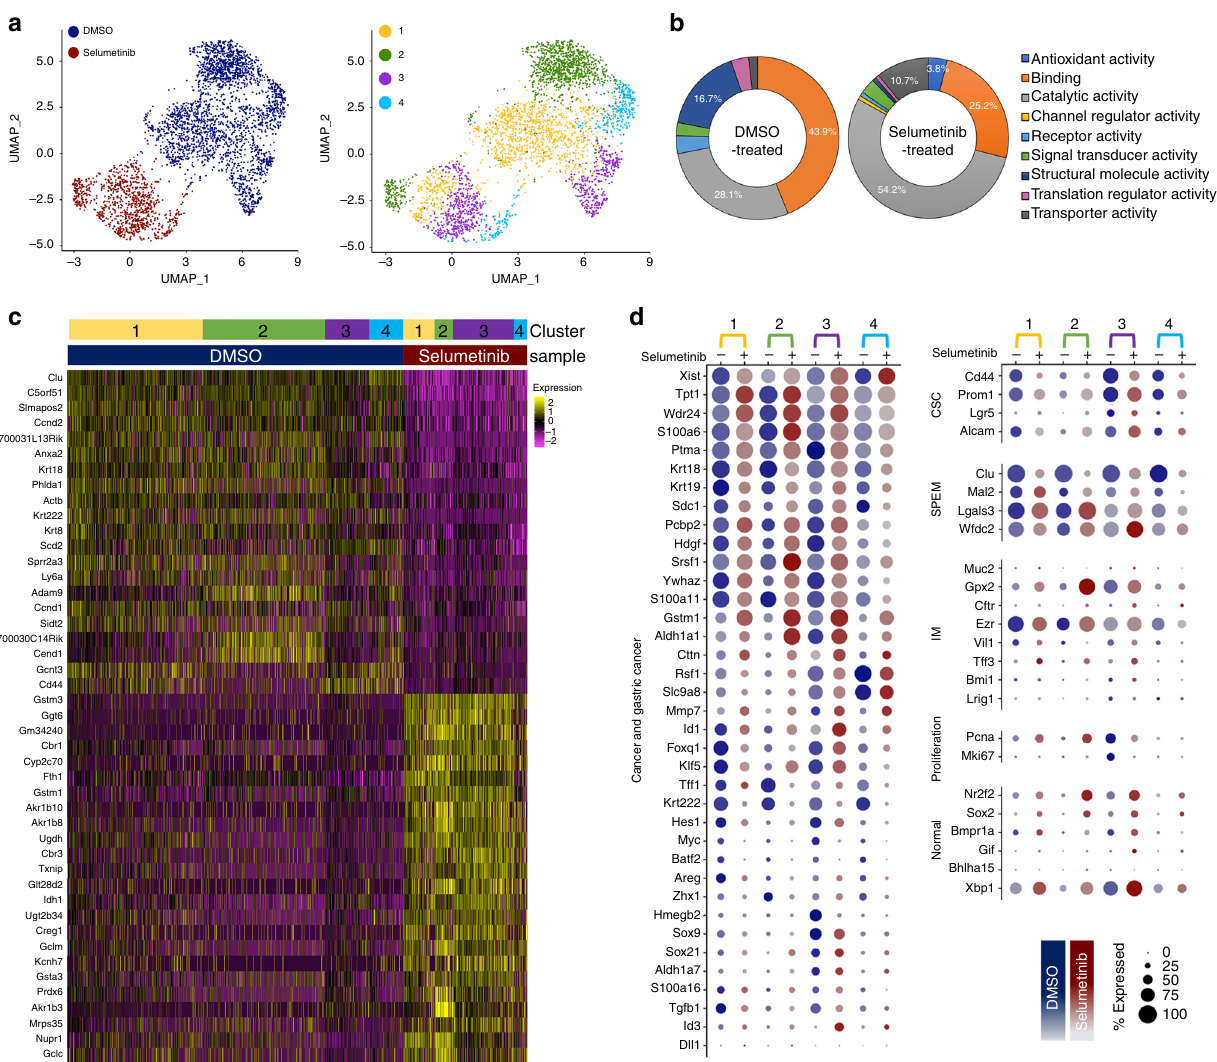
Fig. 6 scRNA-seq analysis of Meta4 cells treated with either DMSO or Selumetinib. a UMAP of DMSO-treated and Selumetinib-treated Meta4 samples with sample overlay (left) and subpopulation-matched cluster overlay (right). b PANTHER gene ontology classi fi cation results from DMSO vehicle-treated and Selumetinib-treated Meta4 samples. Top 300 differentially expressed genes in either DMSO vehicle-treated or Selumetinib-treated Meta4 samples were used for the analysis. c Heatmap of upregulated genes in DMSO vehicle-treated or Selumetinib-treated samples. Upregulated genes were de fi ned as those expressed in at least 50% of the cells in the sample with at least 0.75 log fold-change over the other sample. P -values were calculated using a two- tailed Wilcoxon Rank Sum test with Bonferroni correction and were <1e − 40 . Rows correspond to individual genes and columns are individual cells, arranged by sample and subpopulation. Yellow corresponds to high expression, black corresponds to neither high nor low expression, and purple corresponds to low expression. d Dot plots showing selected markers for cancer and gastric cancer (left), as well as markers for gastric cancer stem cells (GCSCs), SPEM, IM, proliferation, and normal gastric epithelium (right). Results are shown for matched subpopulations (1 – 4) and split by treatment (DMSO vehicle or Selumetinib). The dot size represents the percent of cells within the matched subpopulation with detected expression of the gene and color intensity re fl ects the average expression in those cells with detectable gene